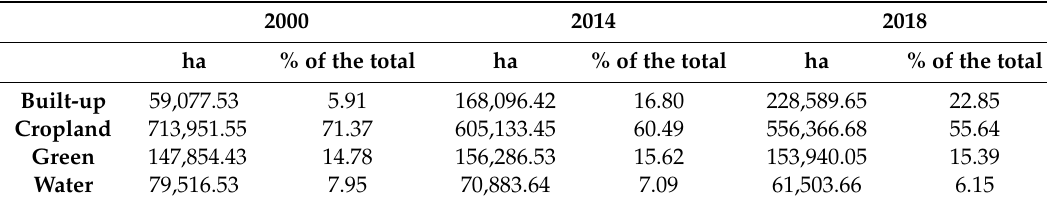
Table 2. Land use / cover (LULC) composition of Nanjing in 2000, 2014, and 2018. Table 2. Land use/cover (LULC) composition of Nanjing in 2000, 2014, and 2018.